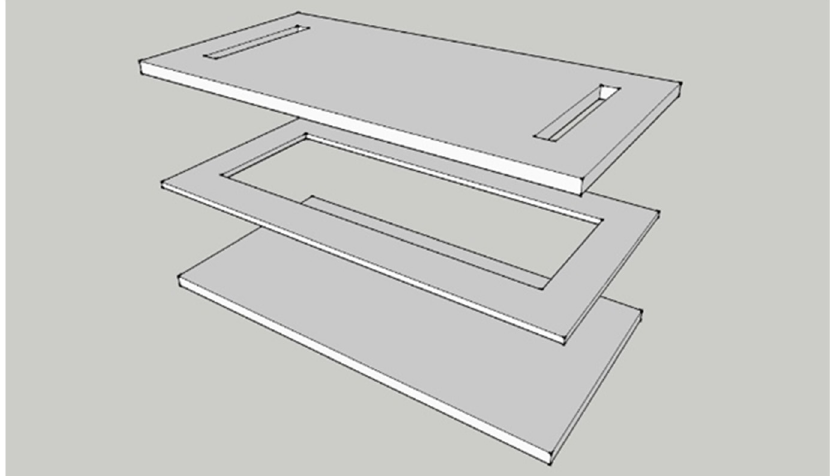
Figure 3. Conceptual illustration of transparent mold.